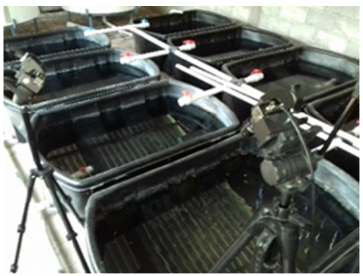
Figure 13. The system used to test the algorithm.